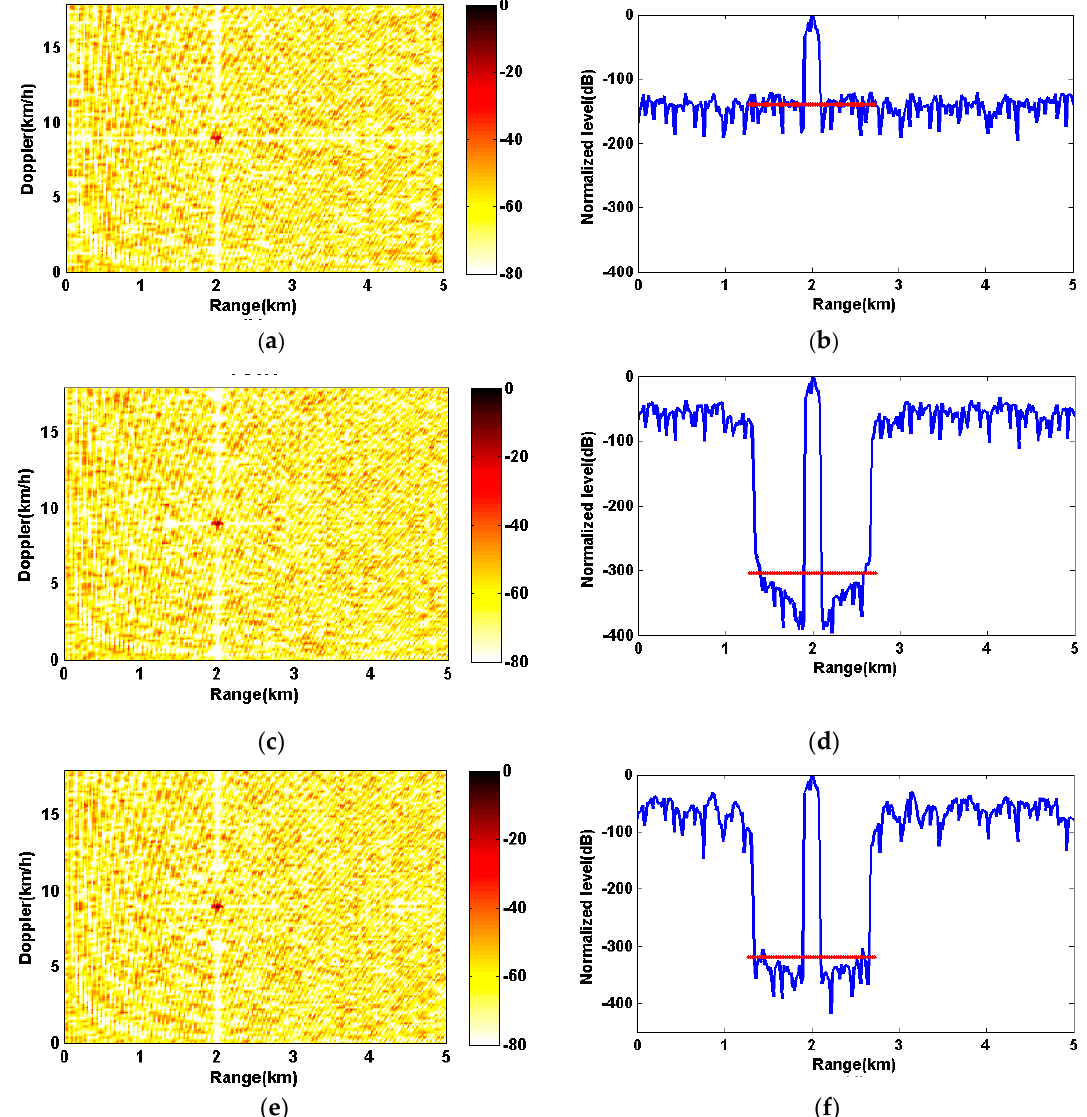
Figure 5. The matched filter performance of the PeISL (PeCAN), PeCA, and the PeWISL sequences. Each sequence has the same carrier frequency, sequence length, and coding width. ( a , c , e ) are the range-Doppler imaging results of three sequences respectively. ( b , d , f ) are the match filter results versus range. The horizontal solid red lines represent the average sidelobe level in the optimized range interval [ 1.28,2.72 ] km.